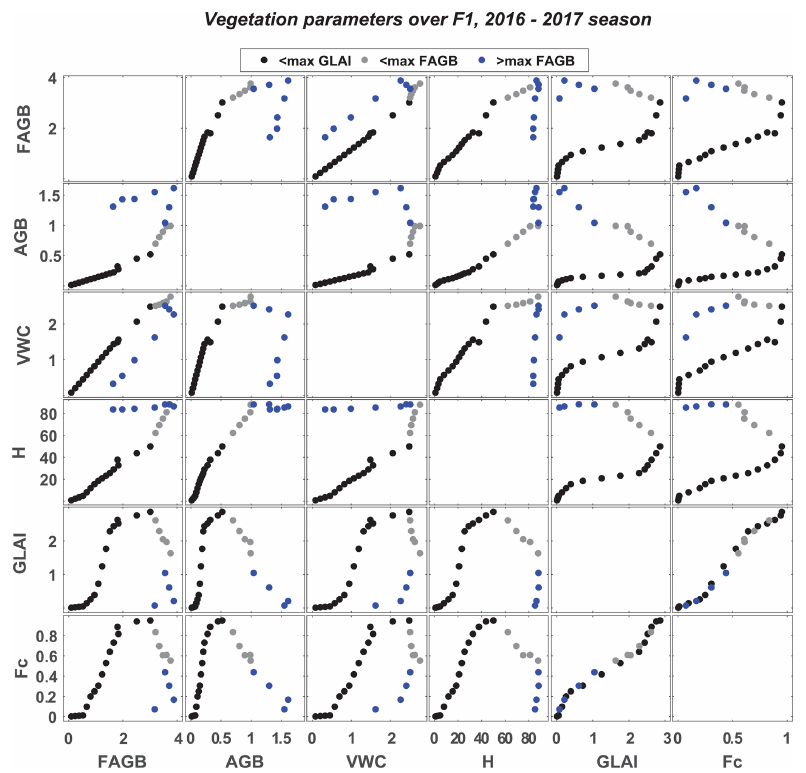
Figure 8. Scatterplots of the relationships between wheat measured variables: FAGB, AGB, VWC, H , GLAI and F C . Data are presented separately using the maximum of the GLAI and FAGB as thresholds: data < max GLAI are in black; data < max FAGB (and > max GLAI) are in grey, and data > max FAGB (and > max GLAI) are in